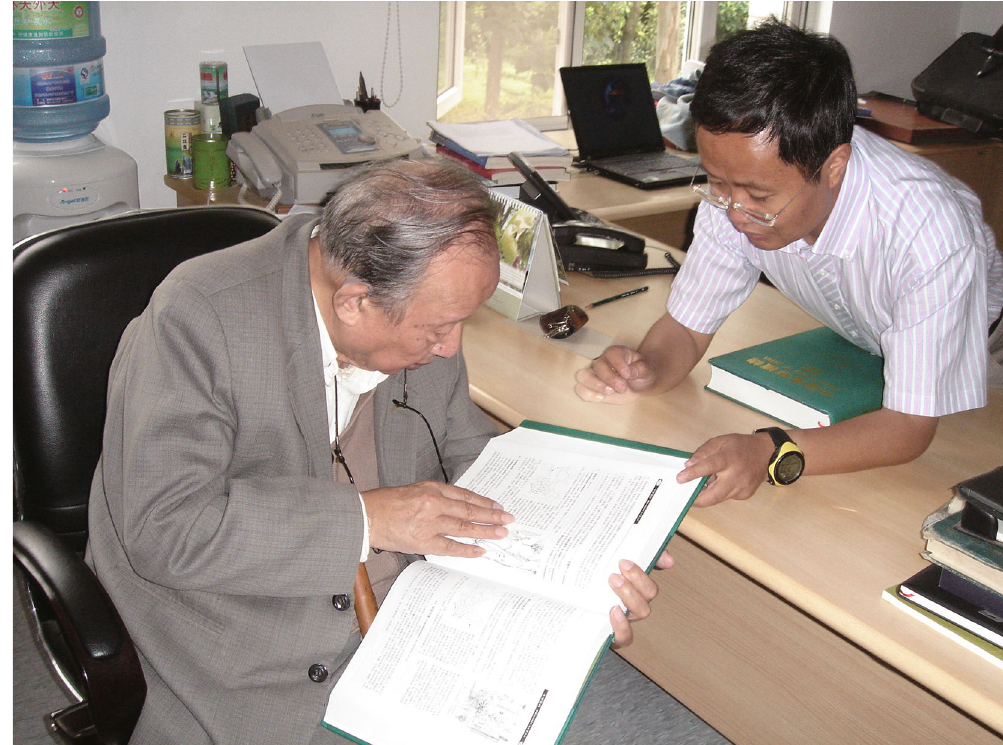
Figure 3. Professor Zhengyi Wu and the author were